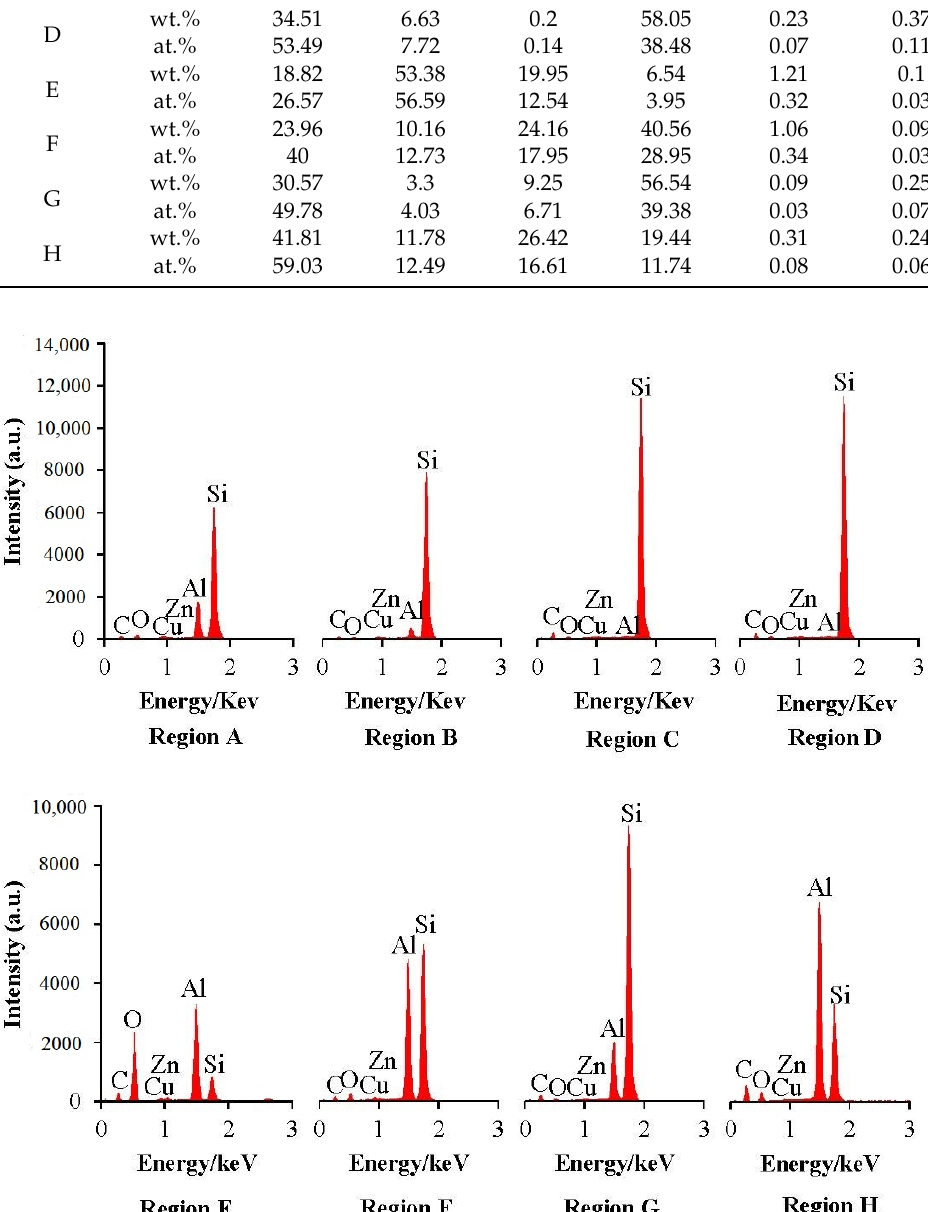
Figure 7. EDS result of the workpiece surface chemical composition.